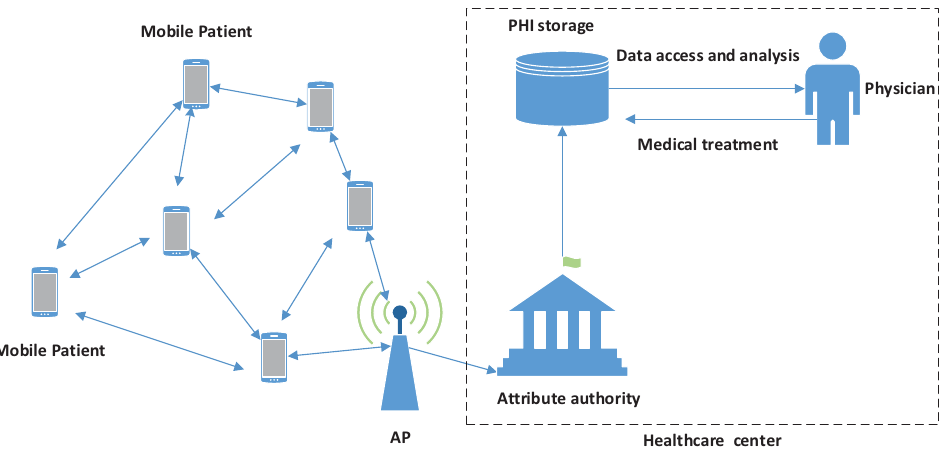
Figure 1. The system model for mobile healthcare social networks